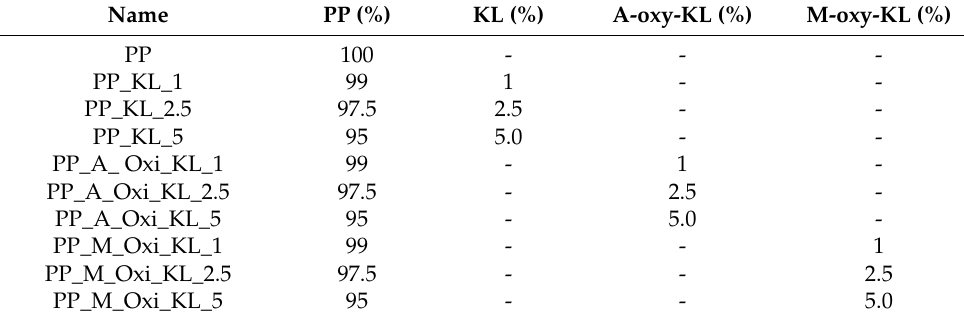
Table 1. Sample nomenclatures and